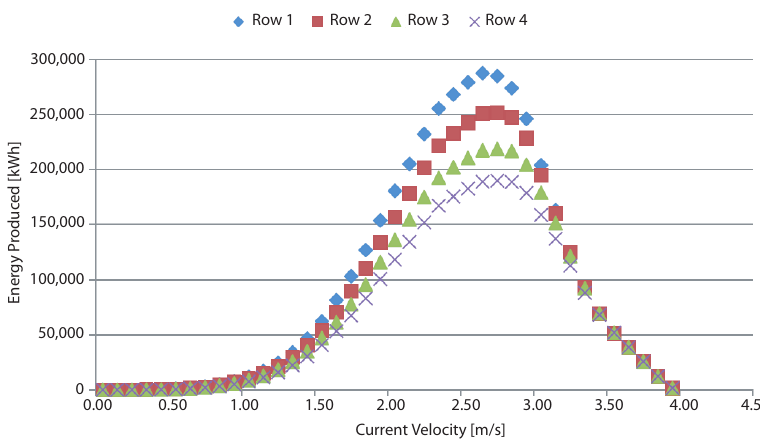
Figure 15. Energy generated by TECs placed in the rows of the TEF.